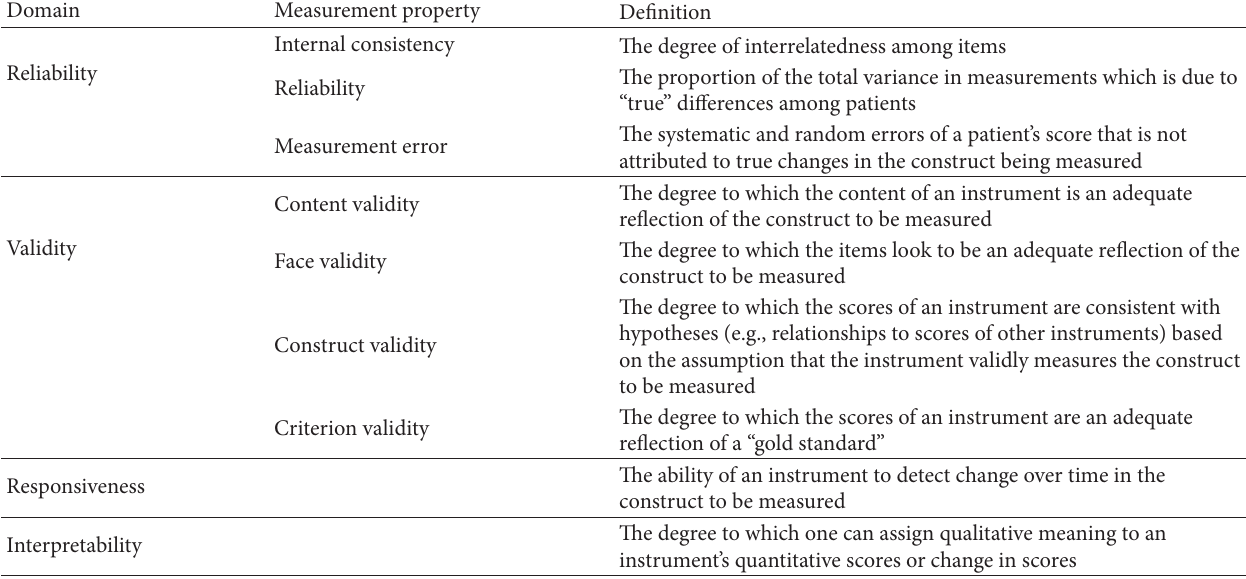
Table 2: Definitions of domains of measurement properties, adapted from COSMIN taxonomy